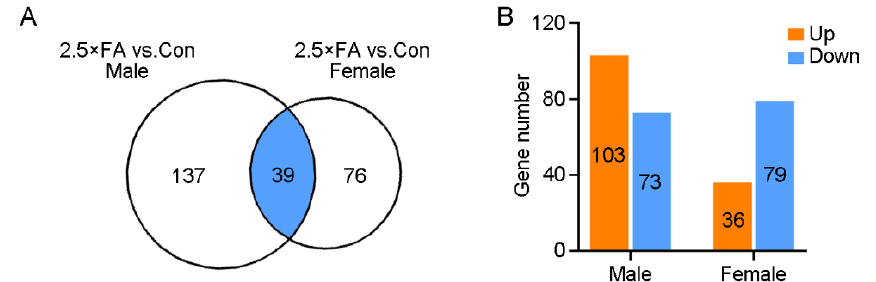
Figure 4. The transcriptome was altered in the brains of 2.5 × FA mice at P21d. RNA extracted from the cerebrum of control and 2.5 × FA mice ( n = 4) was analyzed by transcriptome sequencing. ( A ) Venn diagram indicates the number of DEGs that are unique in each comparison or shared (blue) between groups. ( B ) The number of up-regulated (orange) or down-regulated (blue) genes in 2.5 × FA male or female mice brain.